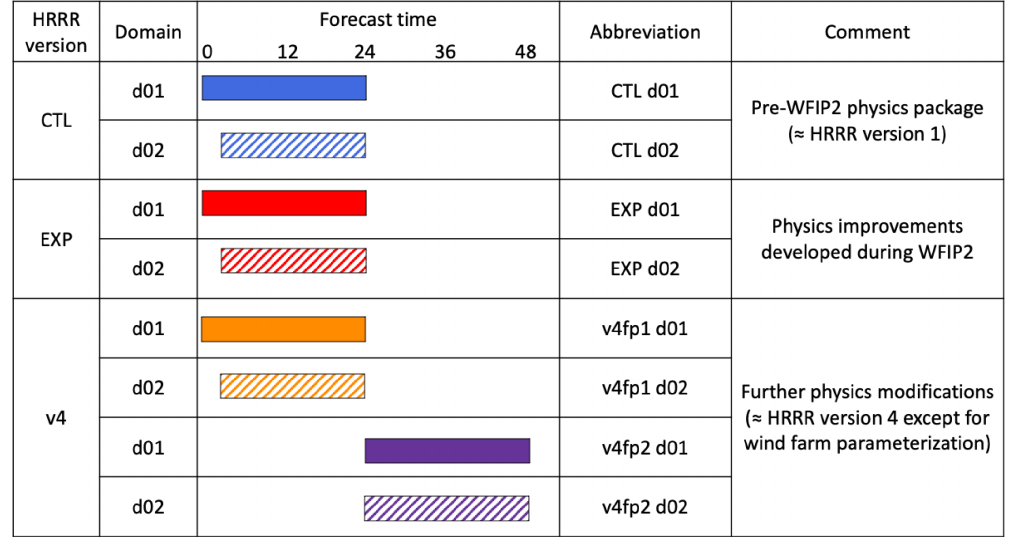
Table 2. Overview of the eight model runs used in this study. Three versions of HRRR (CTL, EXP, and v4) are run for two domains with different horizontal grid spacing (d01: (cid:49)x = 3km; d02: (cid:49)x = 750m). The CTL and EXP runs are 24h forecasts, and the v4 runs are